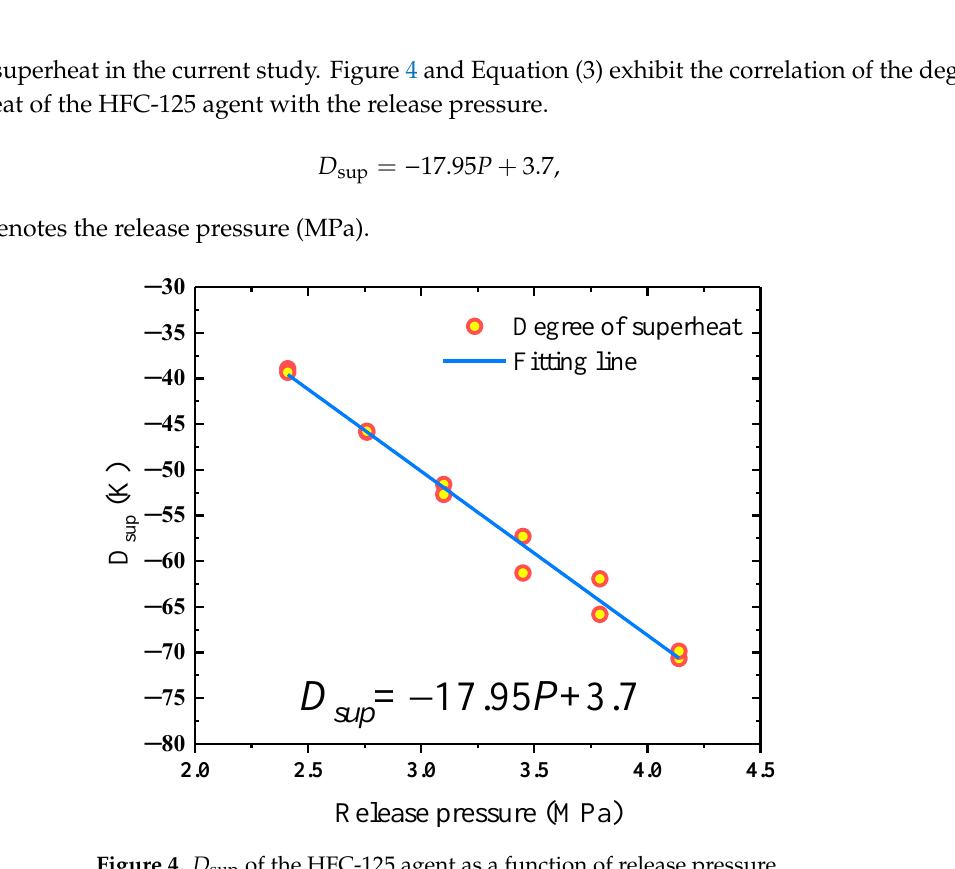
Figure 4. D sup of the HFC-125 agent as a function of release pressure.